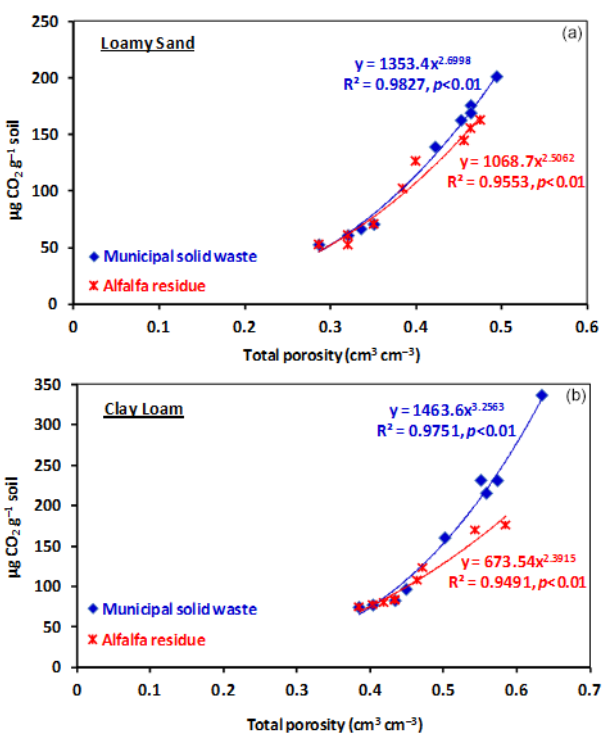
Figure 3. Relationship between the ratio of macroporosity to micro- porosity and soil microbial respiration of loamy sand (a) and clay loam (b) soils, treated with different levels of municipal solid waste (MSW) and alfalfa residue